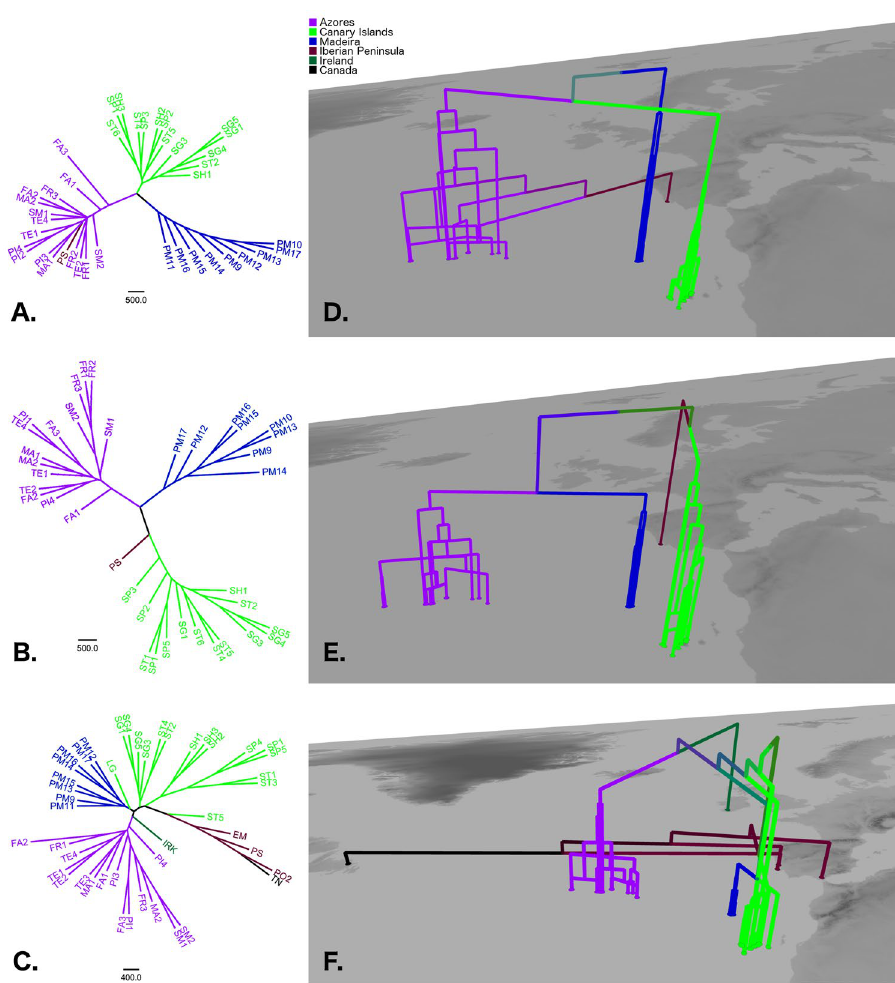
Figure 2. Unrooted population trees and geographic tree models for Lobaria sampled from the Macaronesian islands, the Iberian Peninsula and adjacent areas. Trees are neighbor-joining trees based on chord distance between populations. ( A – C ) Unrooted neighbor-joining population trees based on 1000 bootstrap replicates, created with PHYLIP v. 3.6.9.5, https:// evolu tion. genet ics. washi ngton. edu/ phylip. html, and displayed with FigTree v. 1.3.1. ( D – F ). Midpoint-rooted geographic population tree models from GenGIS v. 2.5.3, https:// beiko lab. cs. dal. ca/ gengis/ Main_ Page. ( A , D ). Lobaria immixta . ( B , E ) L. macaronesica . ( C , F ) L. pulmonaria . The figure was compiled in GIMP v. 2.8, https:// www. gimp.